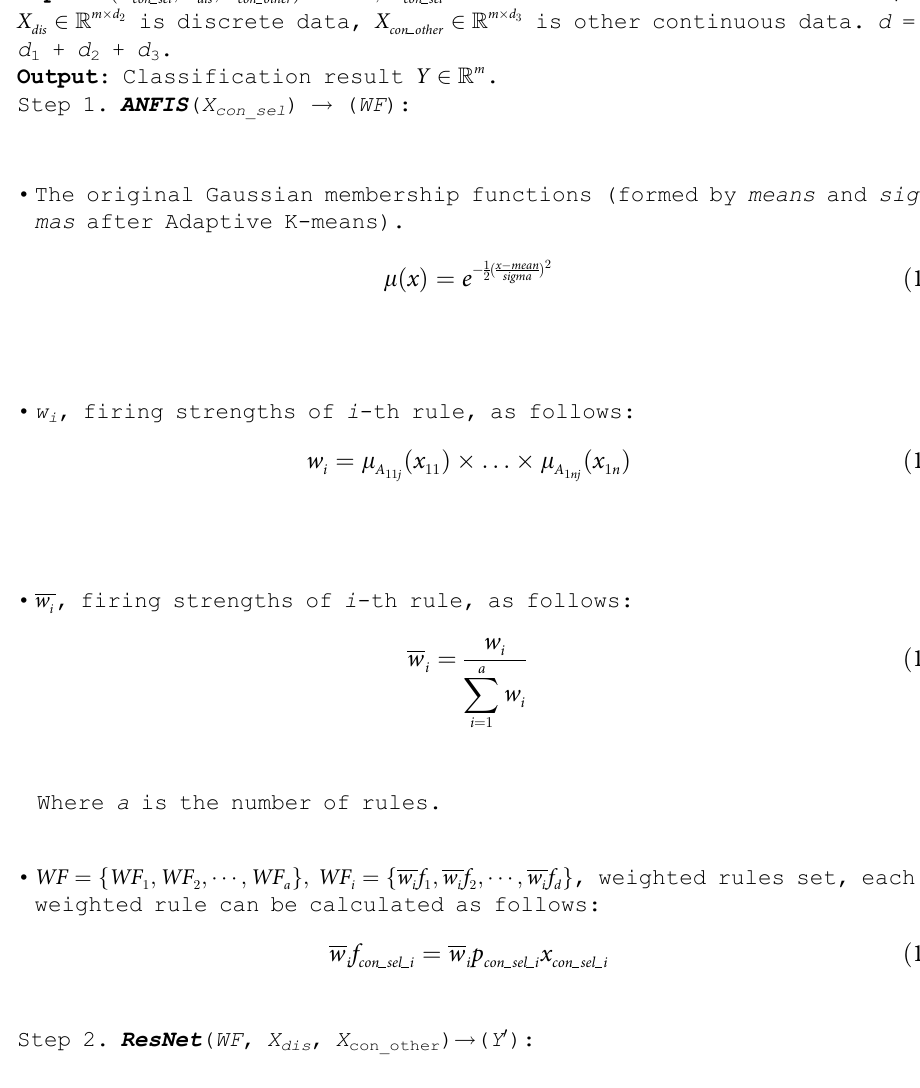
Algorithm 1 The proposed